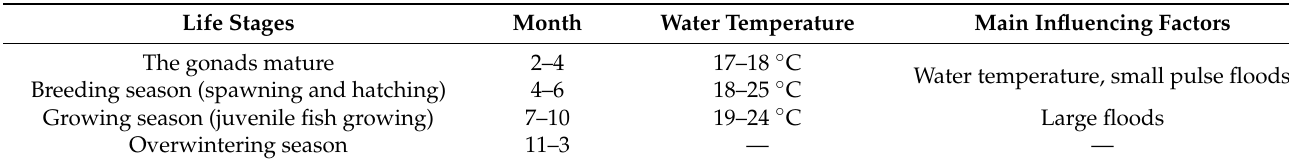
Table 1. Life stages of carp in the Yellow River.